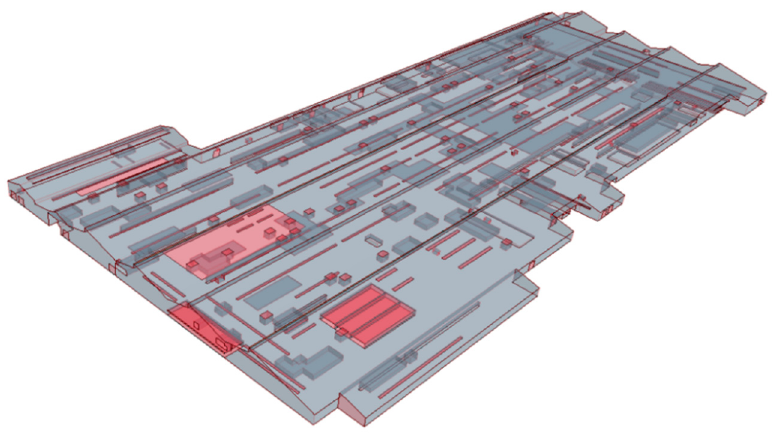
Figure 3. Computational domain of the large-scale assembly factory.